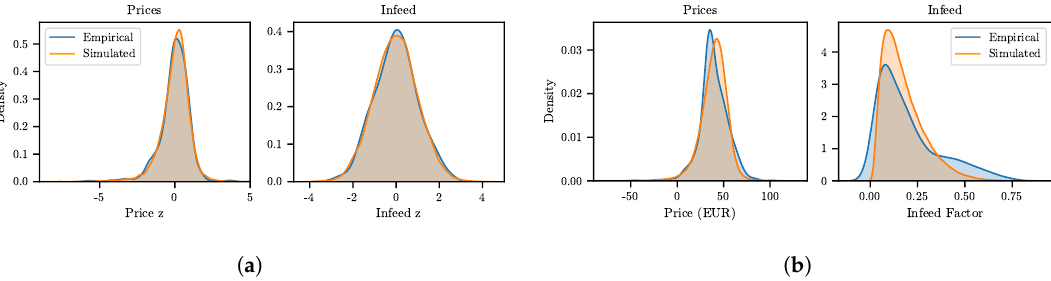
Figure A1. Comparison of the empirical and simulated distributions. ( a ) Comparison of standardized residuals of fitted marginal models and results of copula simulation. ( b ) Comparison of empirical distributions and re-transformed results of copula